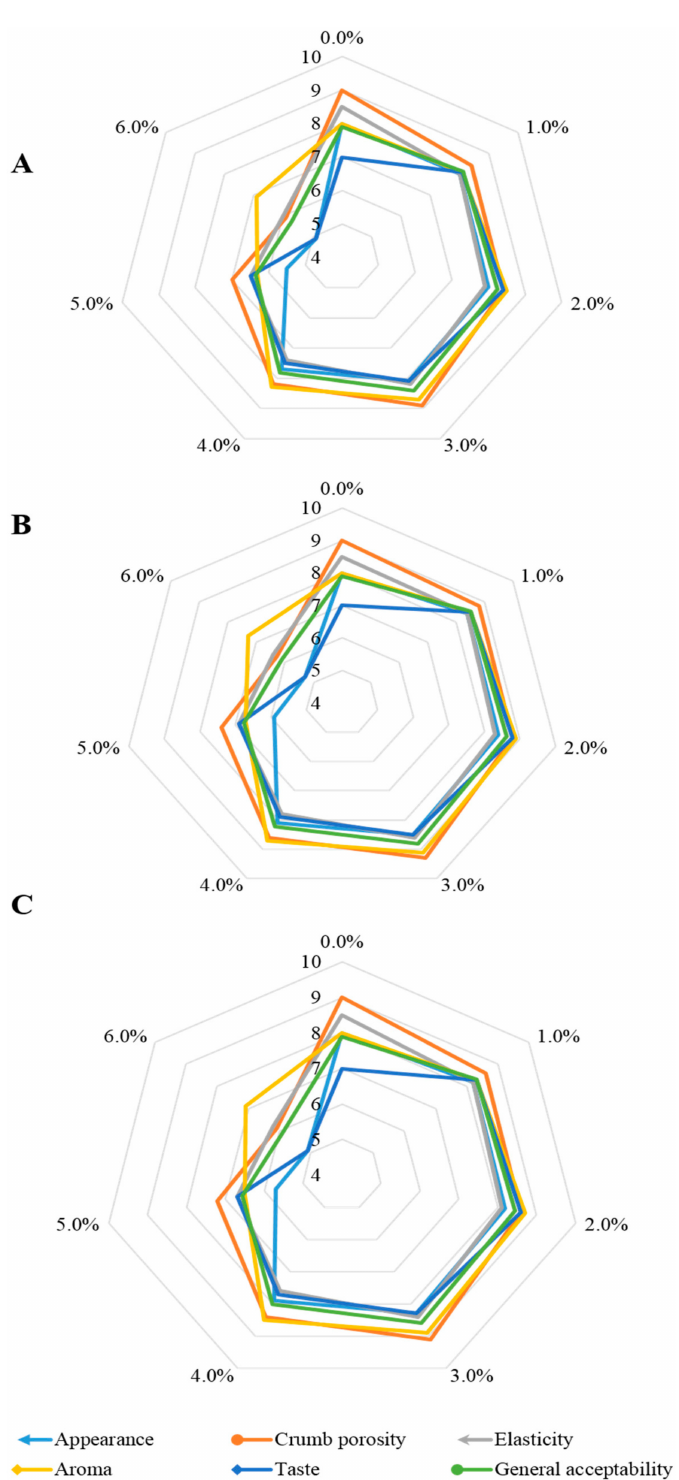
Figure 1. Sensory evaluation of rye bread fortified with fruit powder ( A ), fruit powders covered with maltodextrin ( B ), and fruit powder covered with inulin ( C